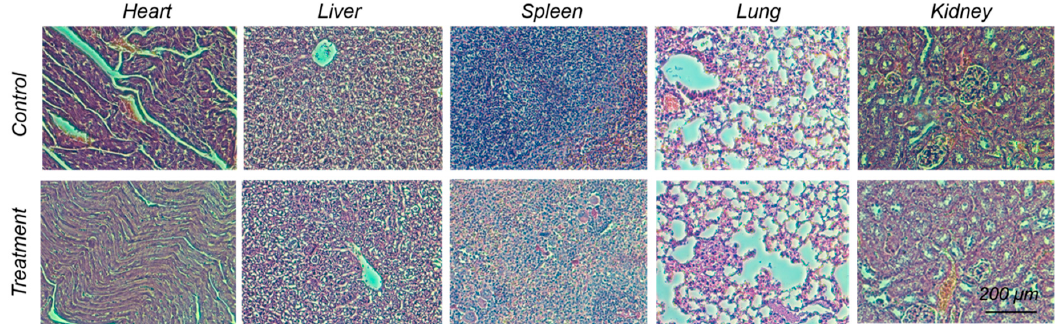
Figure 7. In vivo biocompatibility studies of Mn 3 O 4 @PEG-Cy 7.5 NPs in healthy mice. Hematoxylin and eosin (H&E) staining of major organs from mice after injecting them with Mn 3 O 4 @PEG-Cy 7.5 NPs (dose: 20 mg/kg) at 14 d post-injection. Healthy mice treated with PBS were used as the controls ( n = 3).